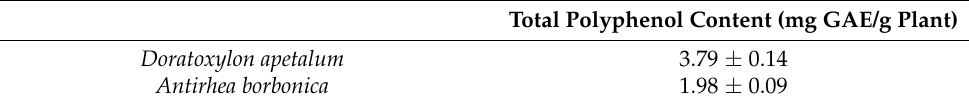
Table 4. Total polyphenol content of D. apetalum and A. borbonica plant